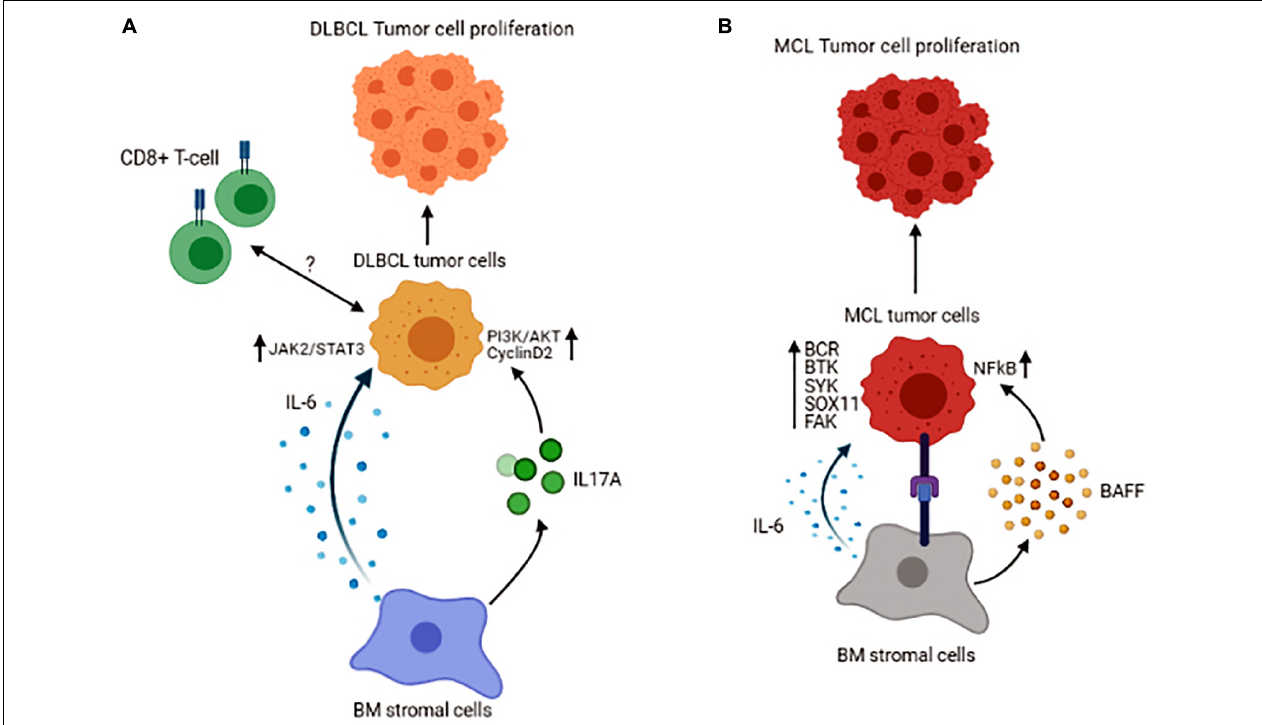
FIGURE 3 | Schematic representation of the tumor cell interactions with its microenvironment in the BM of Diffuse Large B-cell Lymphoma (A) and Mantle Cell Lymphoma (B) . Figures are generated by